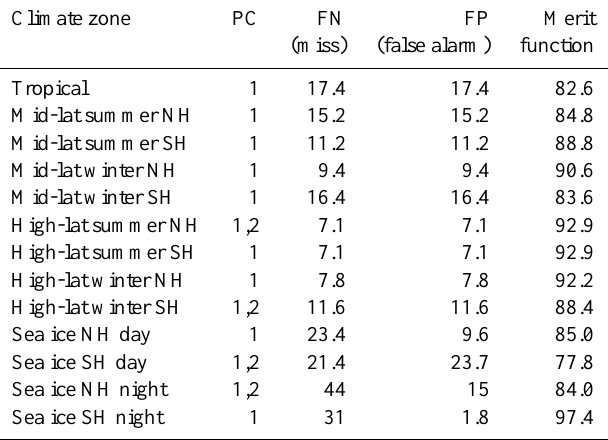
Table 4. CDA results based on coinciding training and test data sets over sea surface and ice. The percentage of hit or success (TP) and of correct non-events (TN) can be obtained by 100 − FP and 100 − FN,